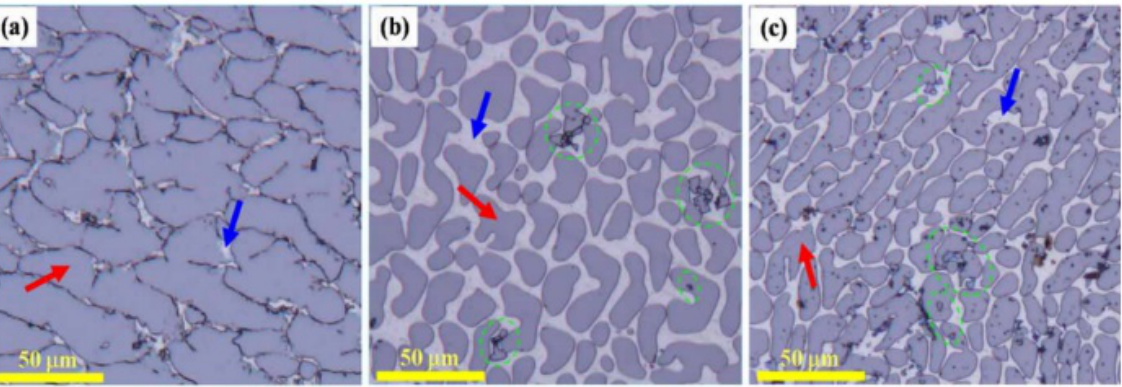
Figure 7. The OM images of as-cast alloys:( a ) Be-Al, ( b ) Be-Al-Sc, and ( c ) Be-Al-Sc-Zr alloys [45] Reprinted/adapted with permission from Ref. [45]. Copyright 2018, Taylor & Francis Ltd.